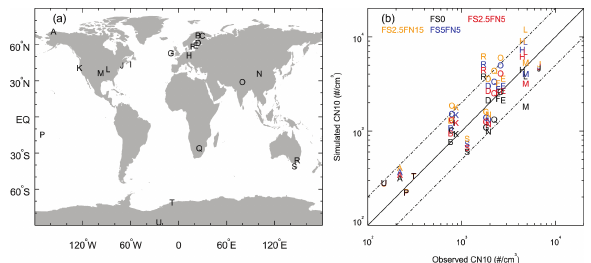
Fig. 5. (a) Locations of aerosol number concentration measure- ments used for simulation evaluation. Letters correspond to those listed in Table 2. (b) Comparison of observed and simulated annual mean number concentrations of CN10 at the 21 low boundary layer sites. The solid line shows a 1:1 ratio and the dashed lines show ratios of 1:2 and